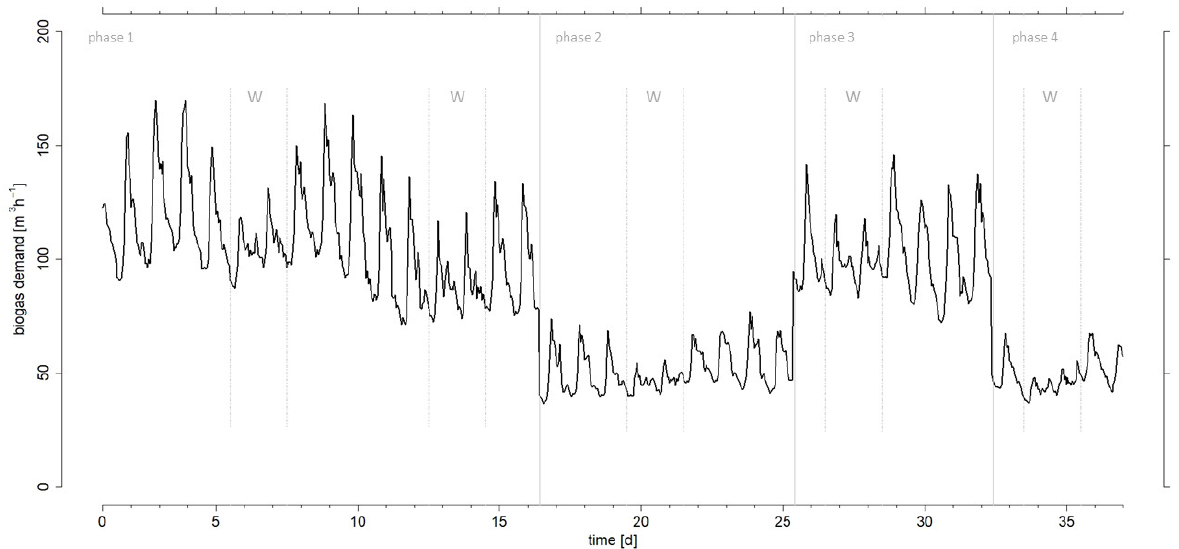
Figure 2. Hourly biogas demand profile over the entire test period, derived from the electricity demand of the “real-world laboratory”. The vertical grey lines identify start and end of the four experimental phases. The weekends are marked with dotted lines and “w”.